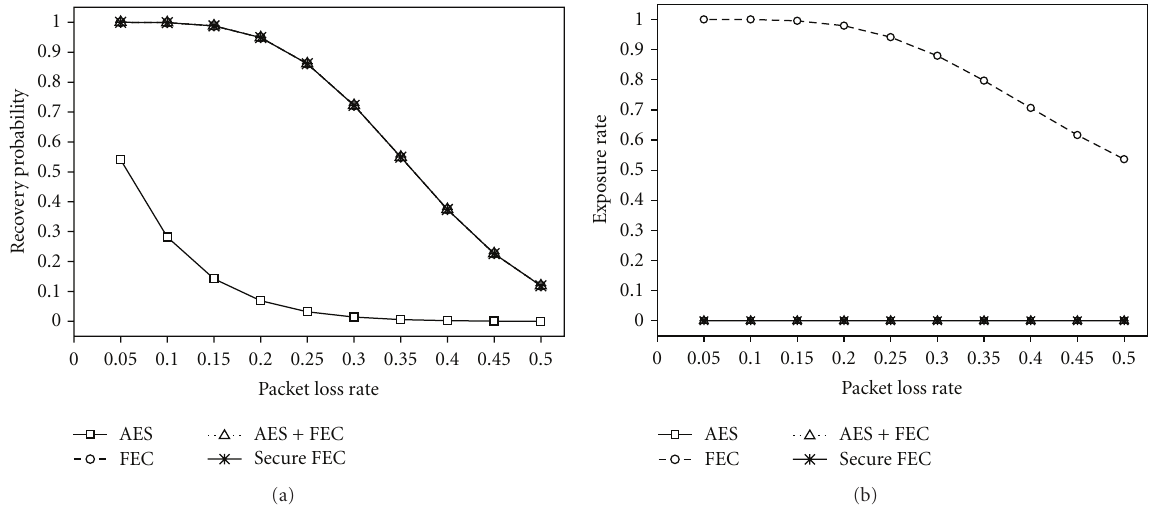
Figure 6: System performance comparison with varied packet loss rates. (a) Recovery probability; (b) exposure rate. Noted that label “FEC” represents the standard FEC.